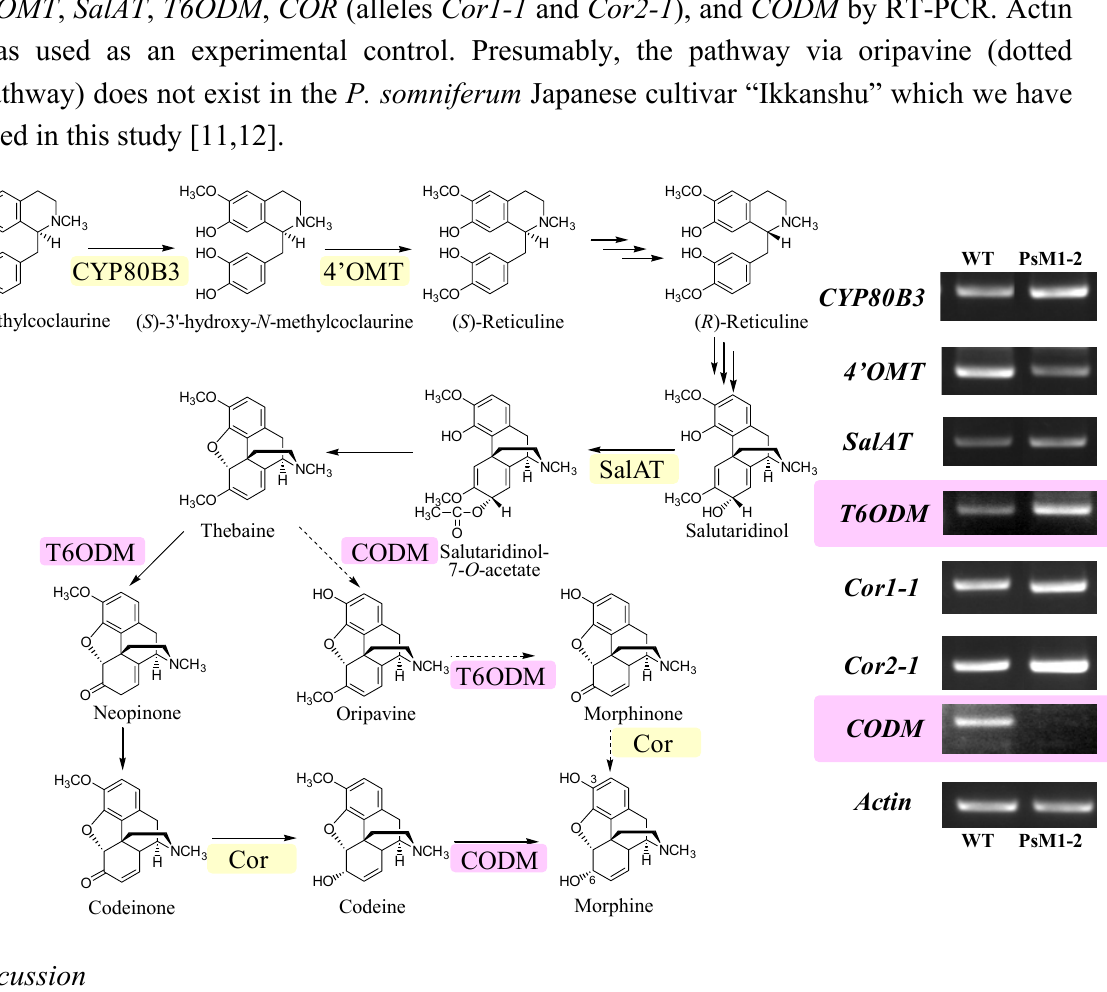
Figure 8. The morphine biosynthetic pathway downstream of ( S )- N -methylcoclaurine with the results of expression analysis of selected morphine biosynthetic genes, CYP80B3 , 4'OMT , SalAT , T6ODM , COR (alleles Cor1-1 and Cor2-1 ), and CODM by RT-PCR.